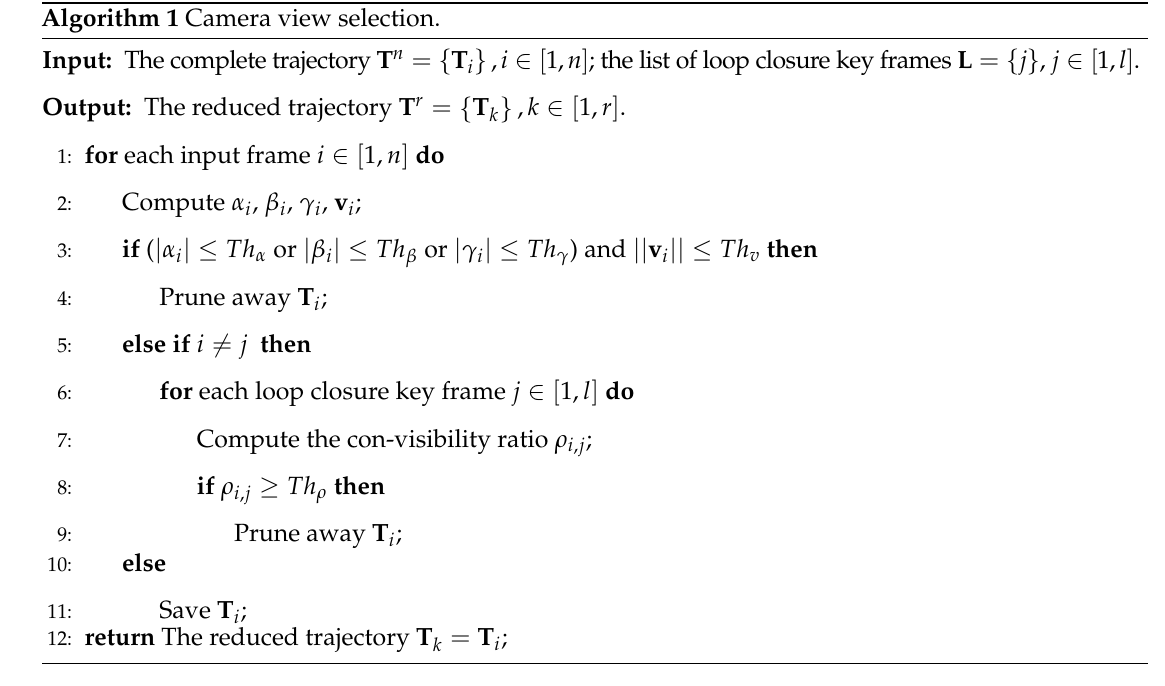
Algorithm 1 Camera view